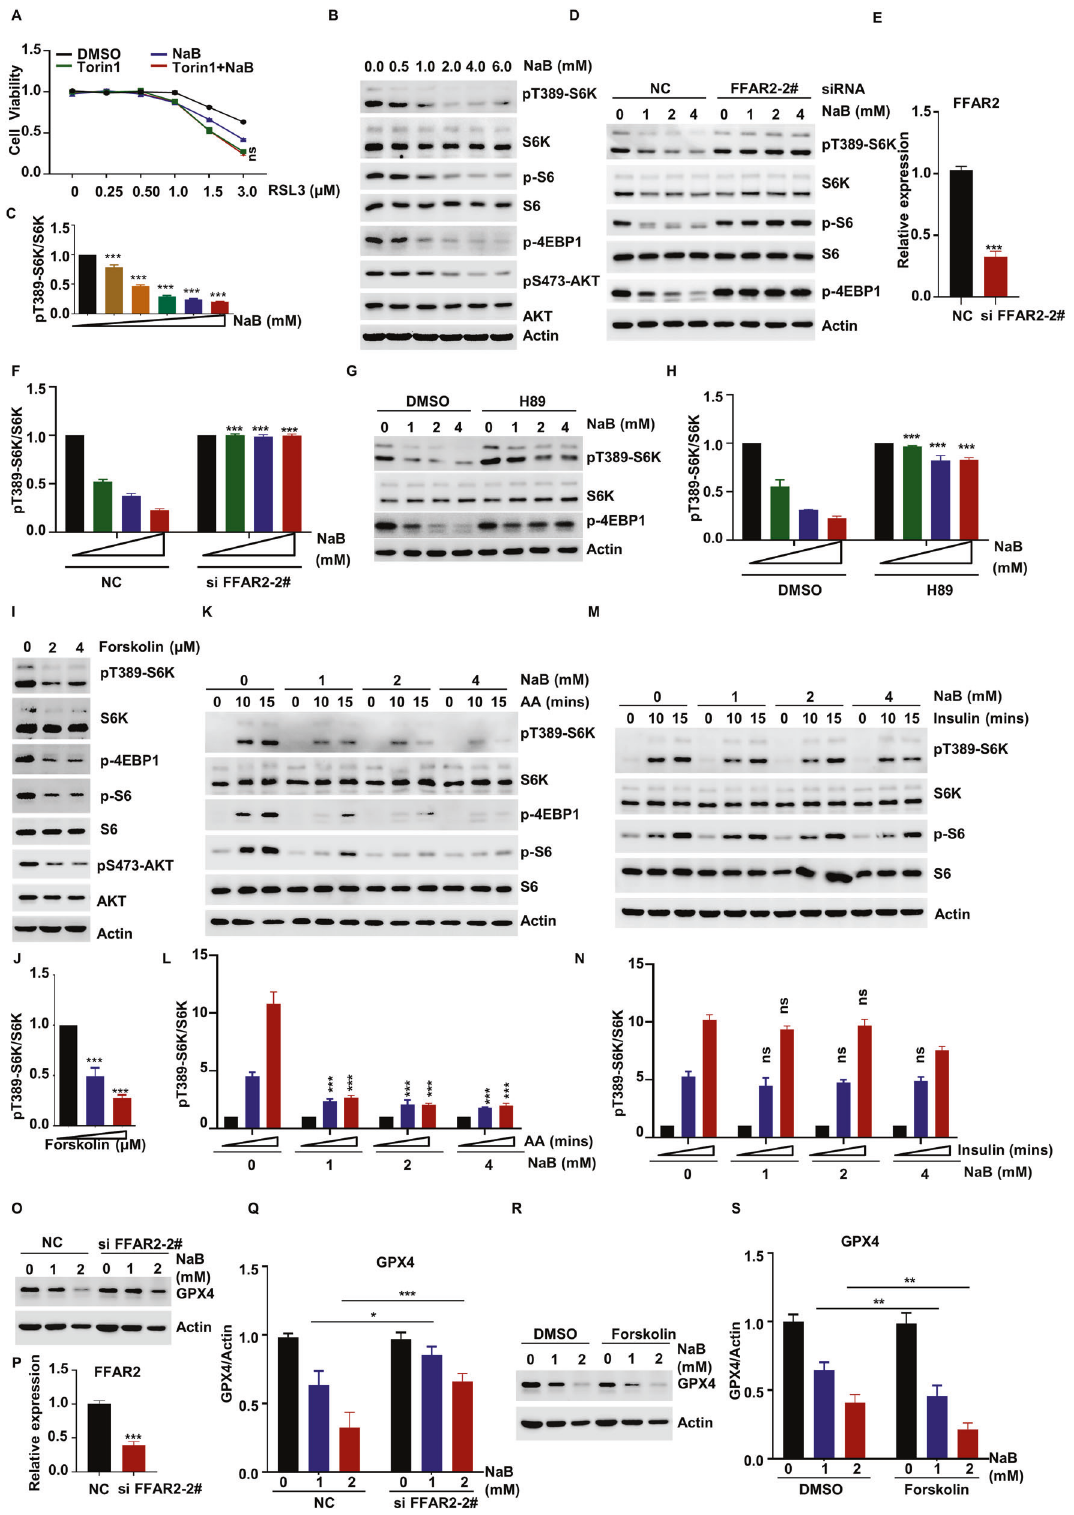
Promotion of ferroptosis by butyrate via inhibition of the AKT and mTORC1 pathway in a cAMP-PKA-dependent manner A recent study showed that mTORC1 inhibited ferroptosis by promoting GPX4 protein synthesis [35]. Next, we examined the role of mTORC1 in regulating NaB-dependent ferroptosis. We